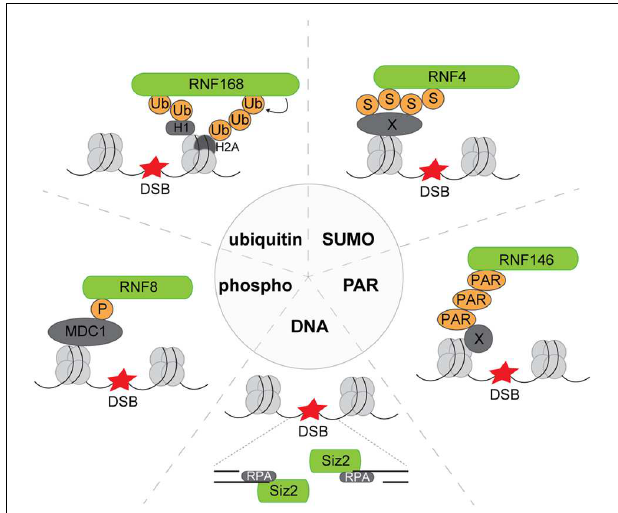
FIGURE 2 | Recruitment modes of exemplary E3 ligases to DNA lesions. Phosphor: phosphorylated MDC1 serves as the recruitment platform for RNF8 to DNA lesions. Ubiquitin: RNF168 binds to both ubiquitylated linker histone H1 and ubiquitylated core histone H2A. SUMO: RNF4 harbors SUMO-interacting motifs by which it can bind to SUMOylated substrates, e.g., MDC1 at DNA lesions. PAR: The E3 ligase RNF146 translocates to DNA breaks and is activated by binding to PARylated substrates. DNA: By binding to ssDNA and RPA, the yeast SUMO ligase Siz2 is recruited to DNA lesions. DSB, DNA double-strand break; Ub, ubiquitin; S, SUMO, small ubiquitin-like modifier; PAR, poly(ADP-ribose); P, phosphate group; X, variable or unspecified